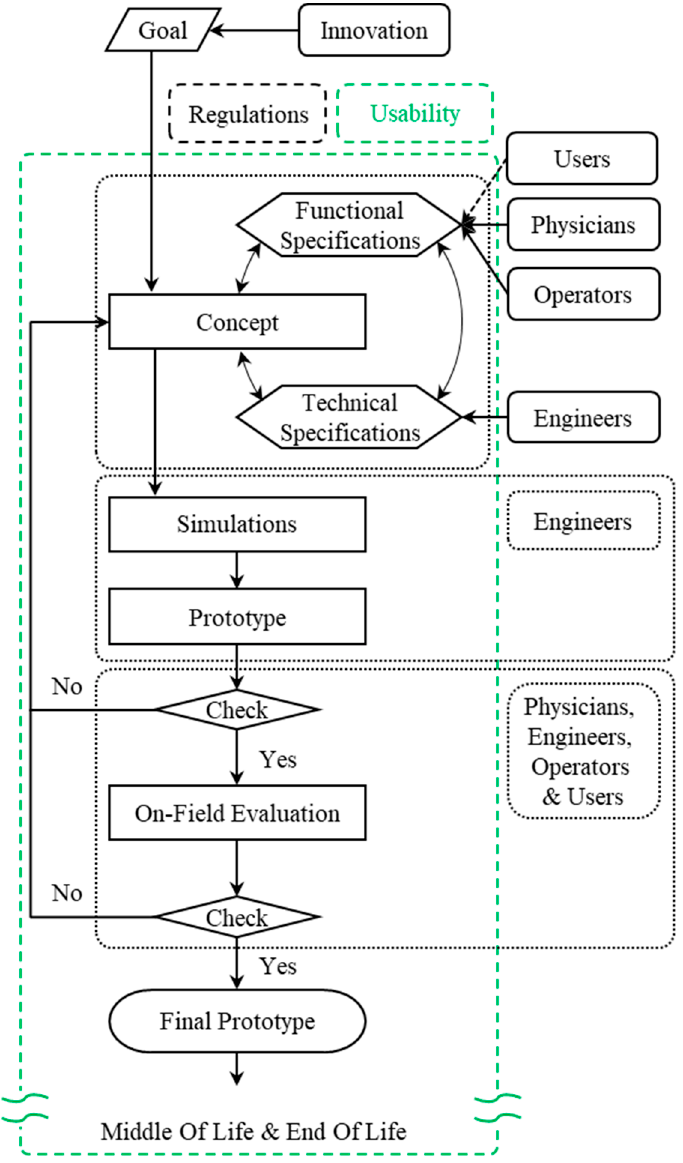
Figure 1. Usability-Oriented Model for the Design of Medical Devices.